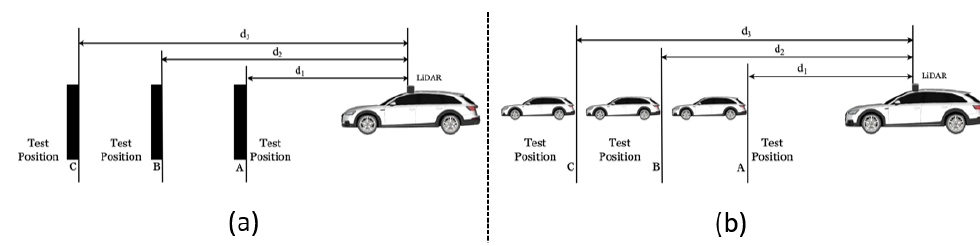
Figure 11. ( a ) Layout of user-selected tests for 10% reflective planar Lambertian target. ( b ) Layout of user-selected tests for the vehicle target.